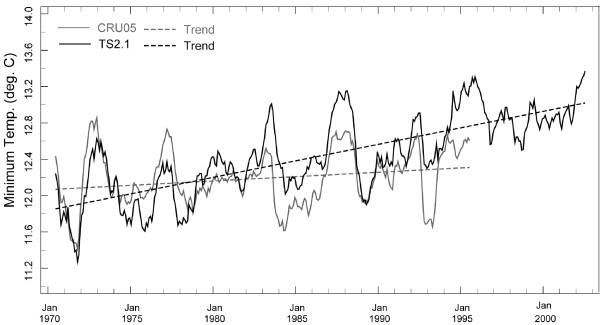
Time series of Tn based on versions CRU05 and v2.1 of the UEA CRU data for the period 1970 to 1995 (CRU05) and 2002 (v.2.1). Best-fit linear regressions are shown as dashed lines for the two versions, which show marked differences.